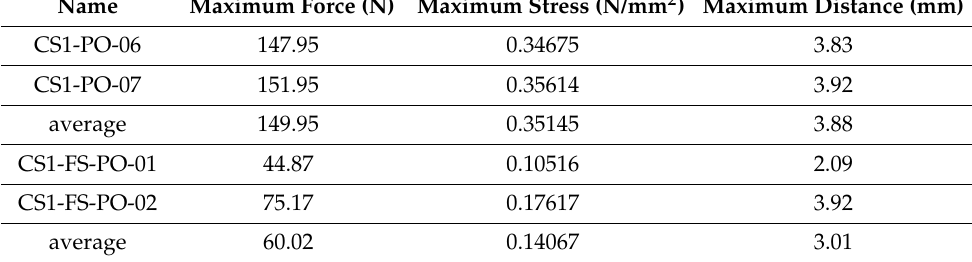
Table 6. Three-point flexural test of bleached cellulose pulp compared to blend of bleached cellulose pulp with beech sawdust.